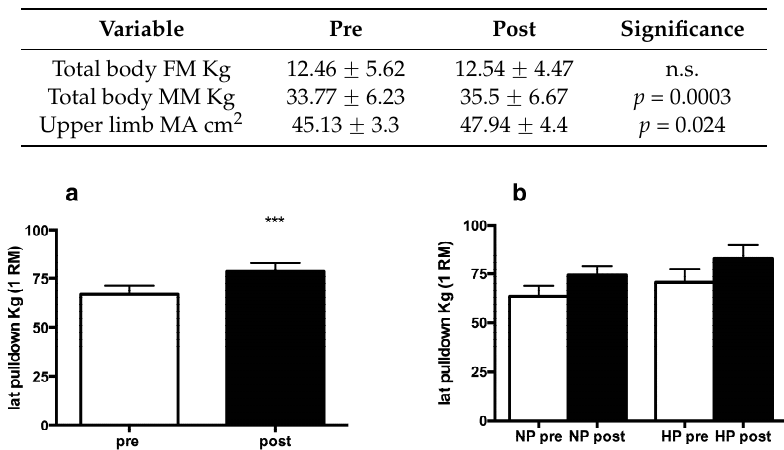
Figure 2. Effects of training and protein amount in diet on 1 RM at latissimus pull down. ( a ) All subjects ( n = 18); ( b ) subjects were divided into high protein (HP, n = 9) and normal protein groups (NP, n = 9). A paired Student’s t ‐ test (merged data) and a mixed model ANOVA (with one between ‐ subjects factor and one within ‐ subjects factor) were used. MEANS and Standard Errors. *** p < 0.001.